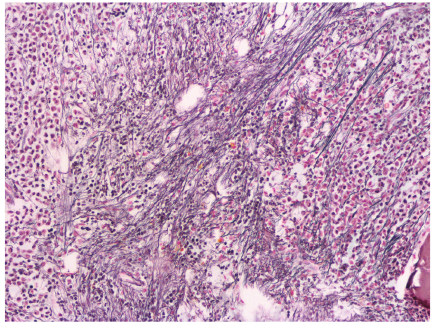
Figure 2: Bone marrow reticulin stain shows severe fibrosis.